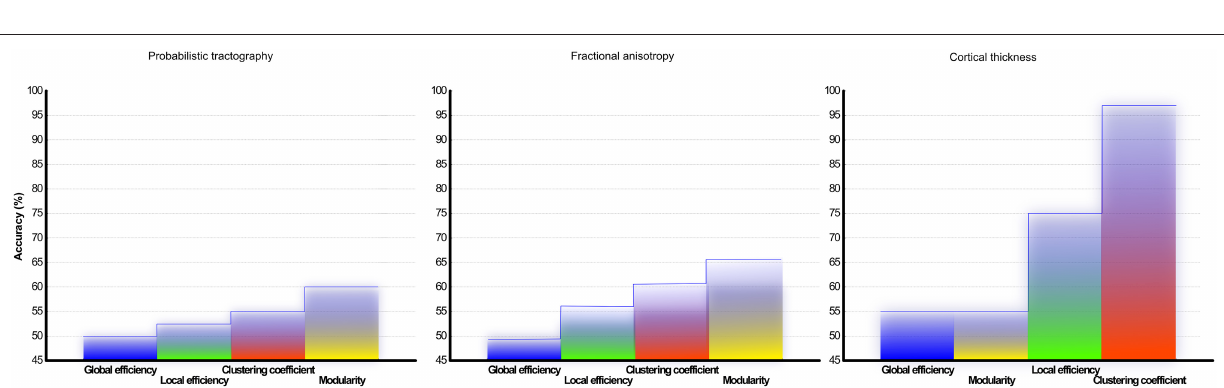
differences predominantly in comparison to healthy controls.